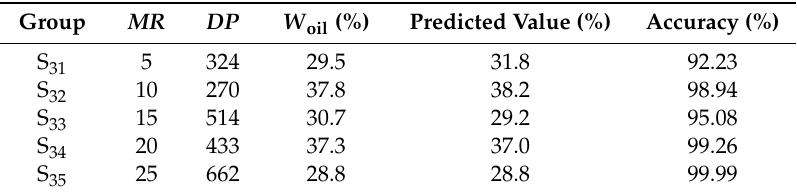
Table 6. Calculation results of the validation groups.